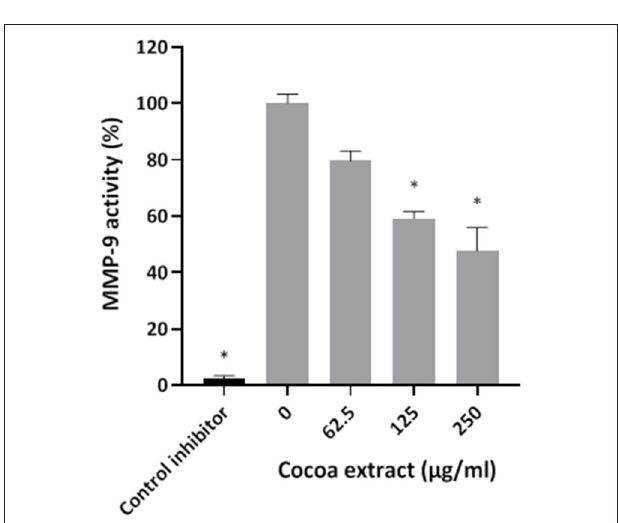
FIGURE 5 | Effect of the cocoa extract on MMP-9 activity. N-isobutyl-N-[4-methoxyphenylsulfonyl]glycyl hydroxamic acid was used as a control inhibitor. MMP-9 activity was monitored by recording the fluorescence at excitation and emission wavelengths of 328 and 420nm, respectively, following a 20-min incubation at 37 ◦ C. A relative value of 100% was assigned to the activity obtained in the absence of the cocoa extract. *significant inhibition ( p < 0.01) compared to the control (no cocoa extract).